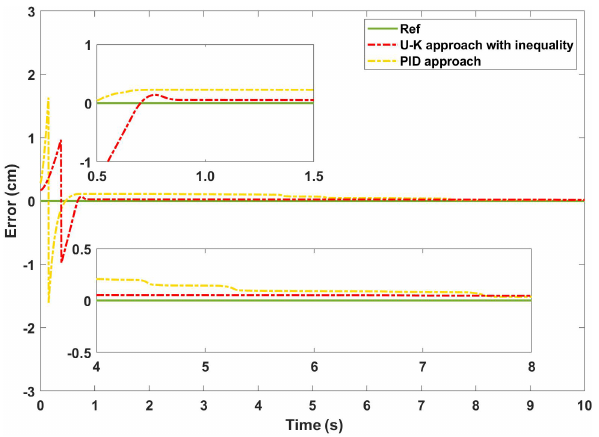
Figure 11. The experimental error of the transient performance of U–K with the inequality constraint and PID.